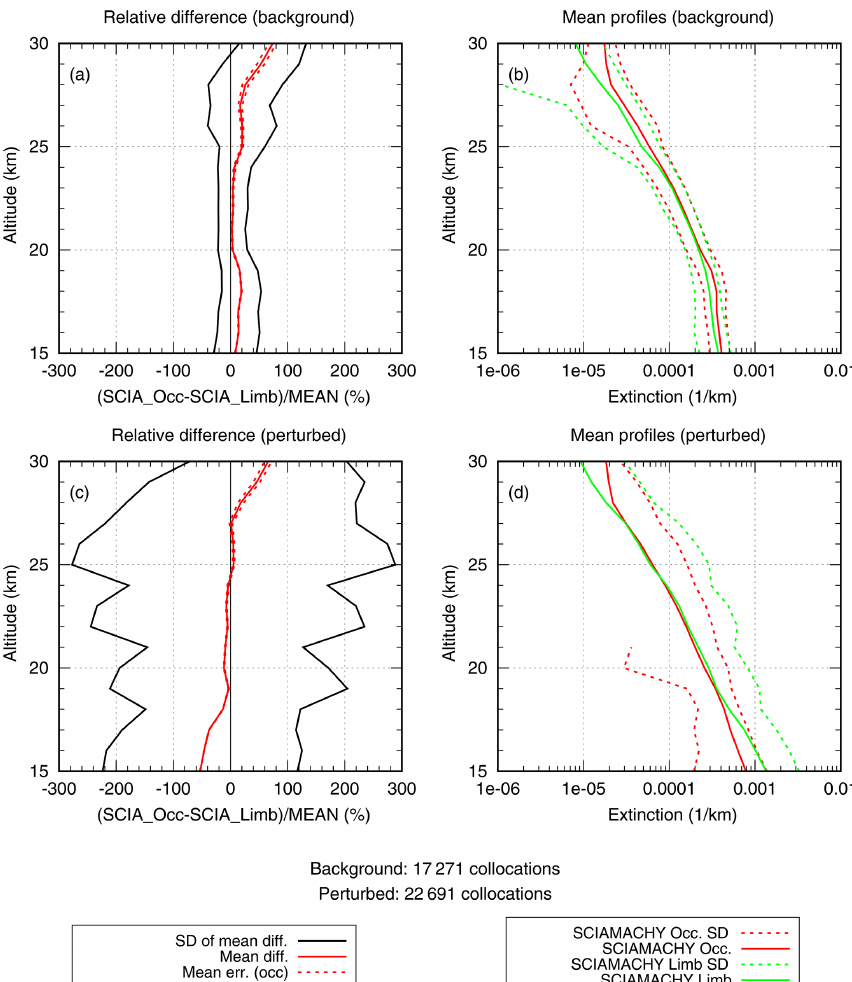
Figure 11. Similar to Fig. 9 but for 750nm and comparison with SCIAMACHY limb aerosol extinctions. (a, b) Results for background times (i.e. aerosol extinctions always < 0 . 001). (c, d) Results for perturbed times (all other